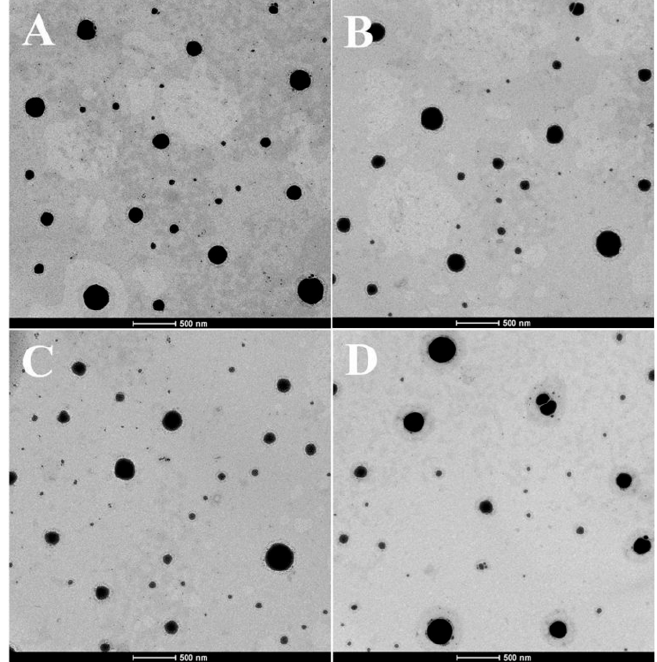
Figure 2. Transmission electron microscopy (TEM) images of different PS-containing Cur-mNLCs. ( A ) 0% PS; ( B ) 4% PS; ( C ) 8% PS; ( D ) 12% PS.